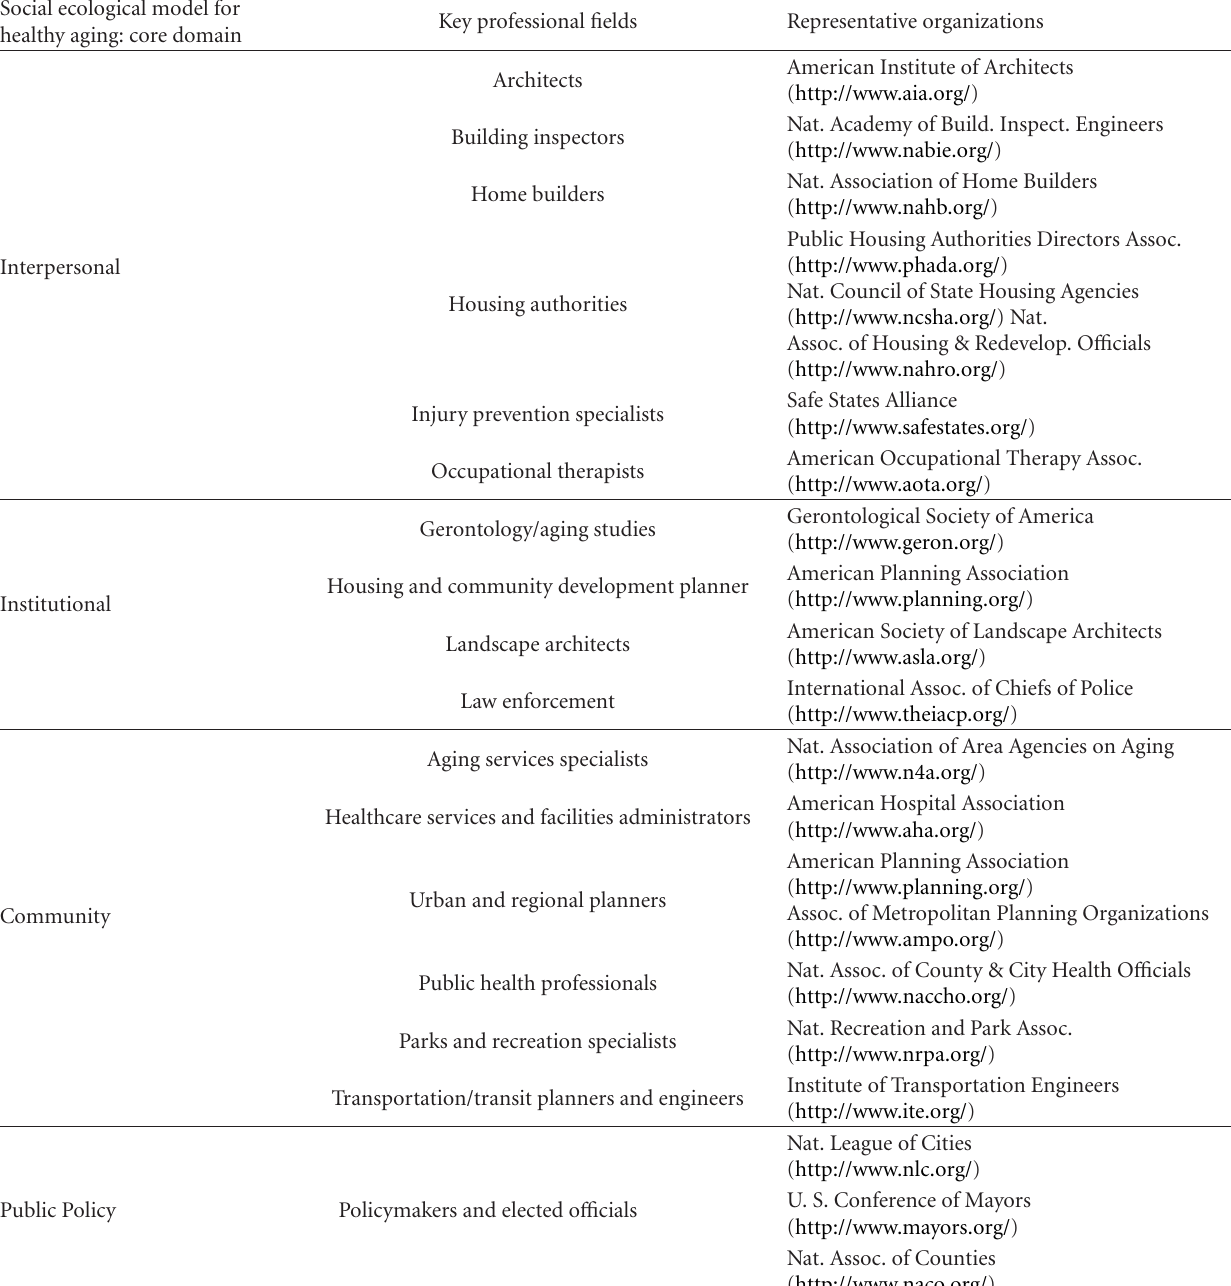
Table 1: Social ecological model for healthy aging domains and their most influential key professions or